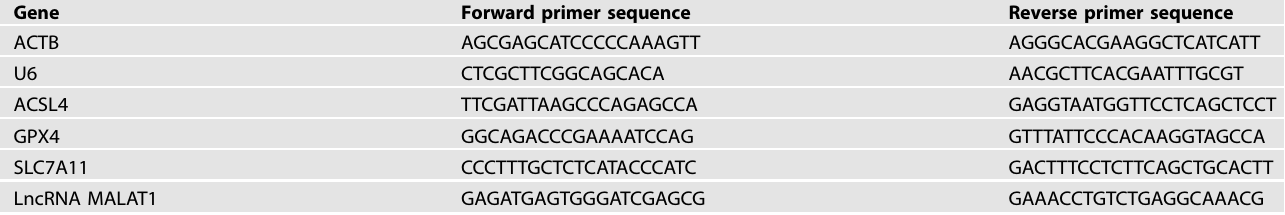
Table 1. Sequences of primers used for qRT-PCR analysis.